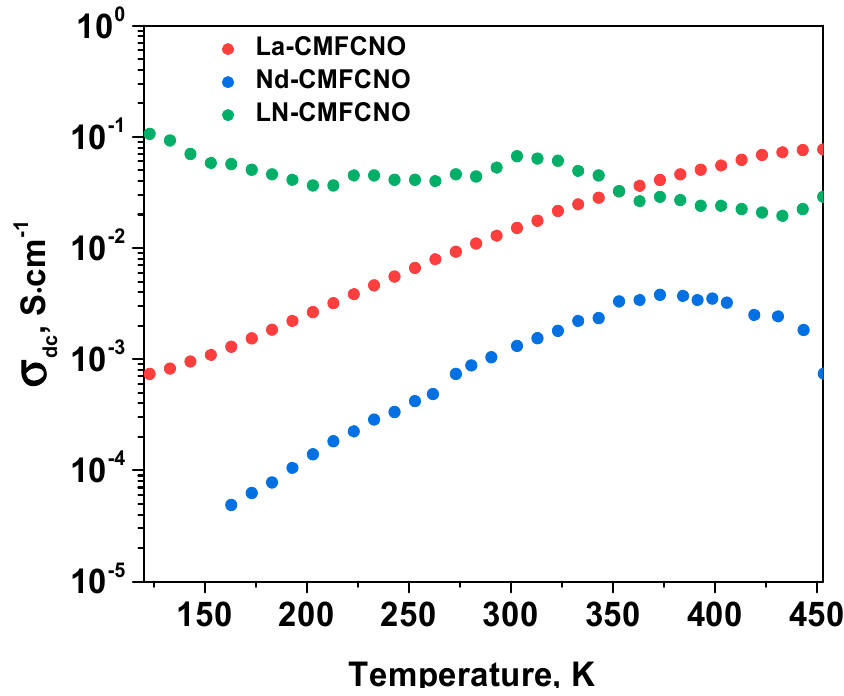
Figure 5. Temperature dependences of the σ DC for the La-CMFCNO, Nd-CMFCNO and LN- CMFCNO ceramic samples.